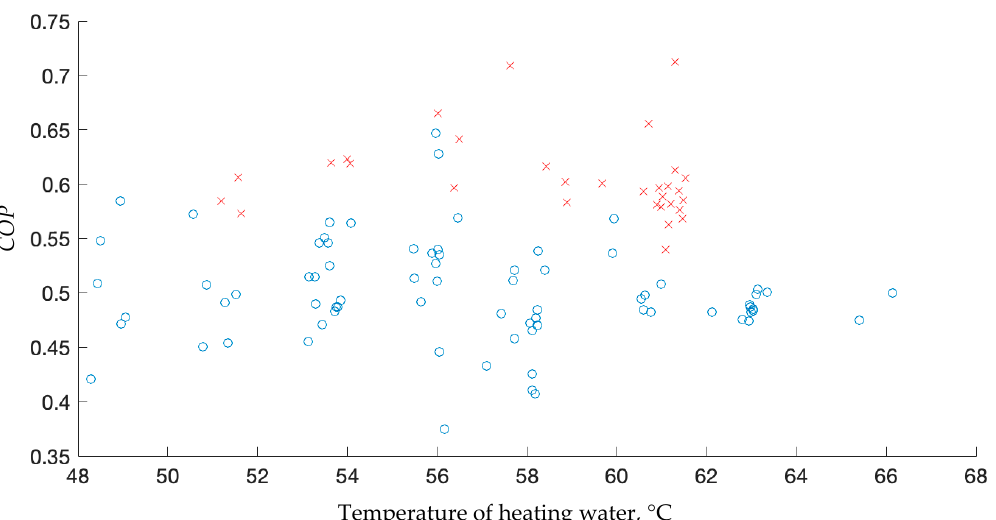
Figure 10. COP with respect to the temperature of the heating water, with cooling water temperature at 25 ℃ and a switching time of 800–1000 s. Blue circles—original control system, red crosses—new control system.